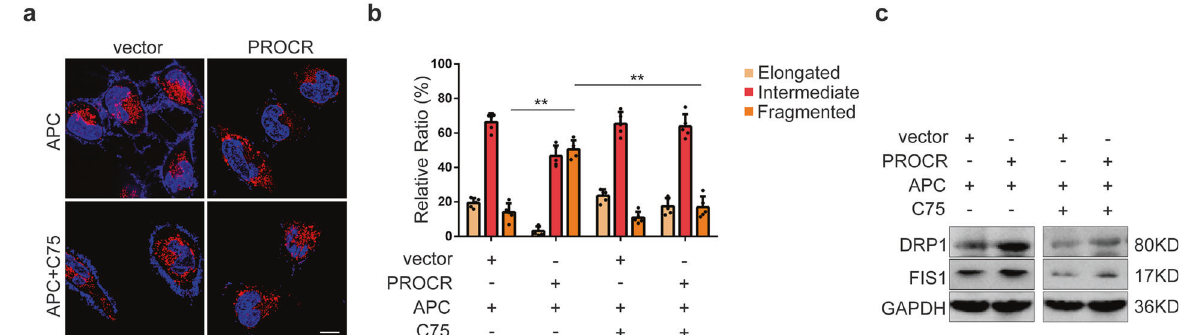
Fig. 4 PROCR triggers mitochondrial fi ssion through activating lipid synthesis. a Mitochondrial dynamics labeled by MitoTracker staining in tumor cells with APC or C75 treatment. C75, FASN inhibitor. Scale bar denotes 10 µm. b Quanti fi cation of the proportion of mitochondria with three different statuses. The relative number of mitochondria with different statuses was counted from about 100 cells in each treatment group. ** P < 0.01. c Western blot examination of genes expression essential for mitochondrial fi ssion in NPC cells with different